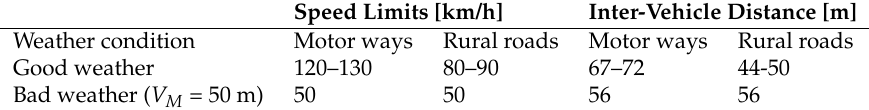
Table 1. Inter-vehicle distances based on the weather condition based on regulations in